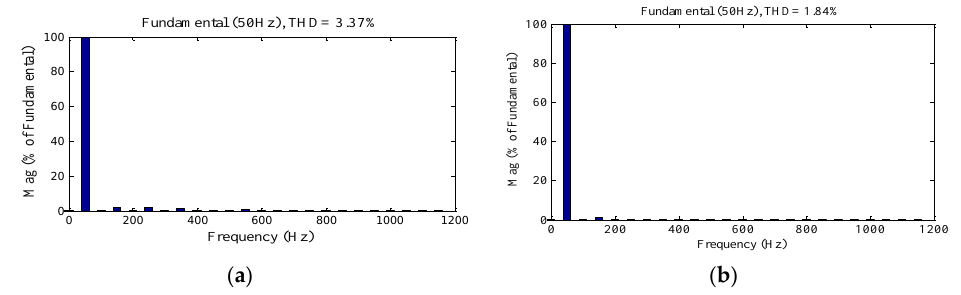
Figure 16. The comparison of Fast Fourier Transform (FFT) analysis of THD of output voltage with filter for PV based boost converter obtained using ( a ) P&O MPPT technique ( b ) FLC MPPT technique.